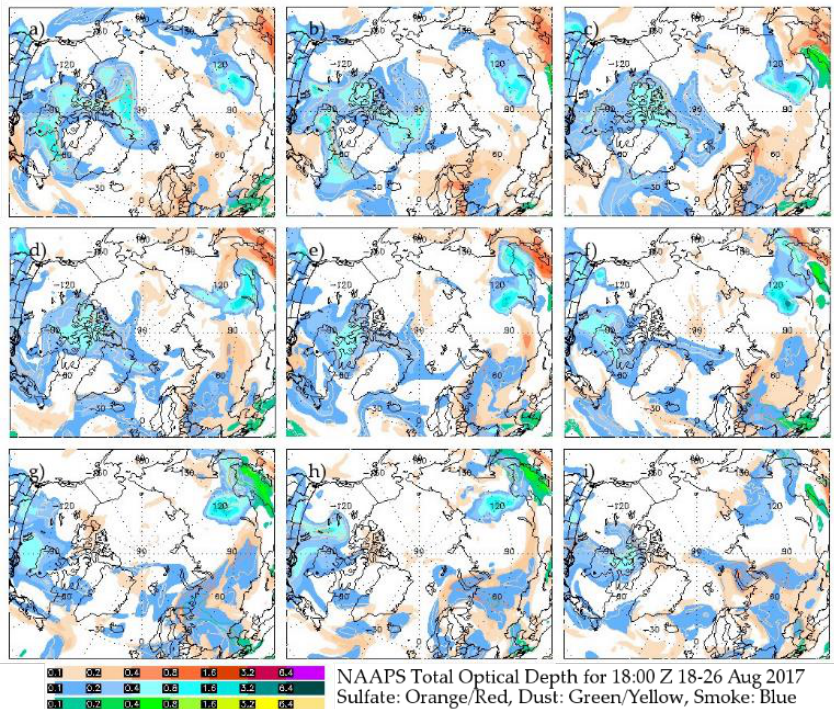
Figure 10. NAAPS Total Optical Depth, aerosol smoke over Spitsbergen in ( a ) 18:00 UTC 18 August, ( b ) 18:00 UTC 19 August, ( c ) 18:00 UTC 20 August, ( d ) 18:00 UTC 21 August, ( e ) 18:00 UTC 22 August, ( f ) 18:00 UTC 23 August, ( g ) 18:00 UTC 24 August, ( h ) 18:00 UTC 25 August, and ( i ) 18:00 UTC 26 August 2017.